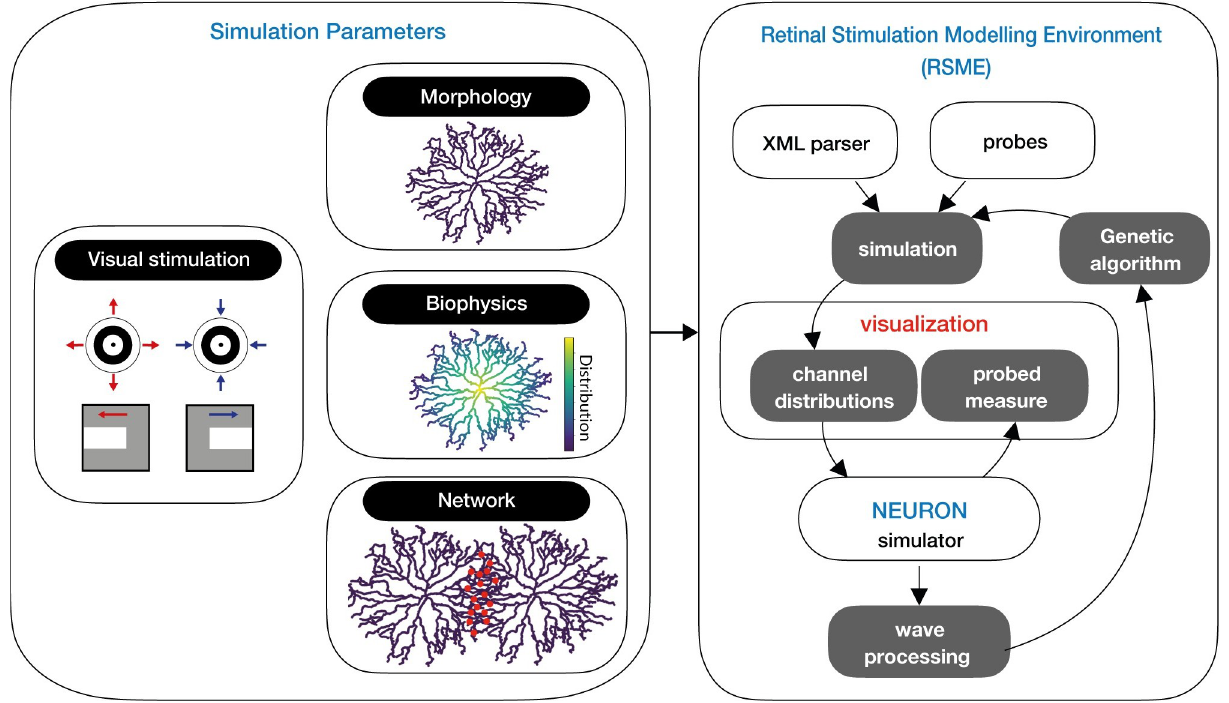
Fig 2. RSME schematic. RSME is comprised of model specifications and a simulation environment. Parameters include the visual stimulation pattern, cellular morphology and biophysics, and network organization. Simulation parameters are parsed and visualized within the modeling environment and used to simulate over NEURON. RSME permits the utilization of signal processing for local optimization (e.g., via a genetic algorithm).